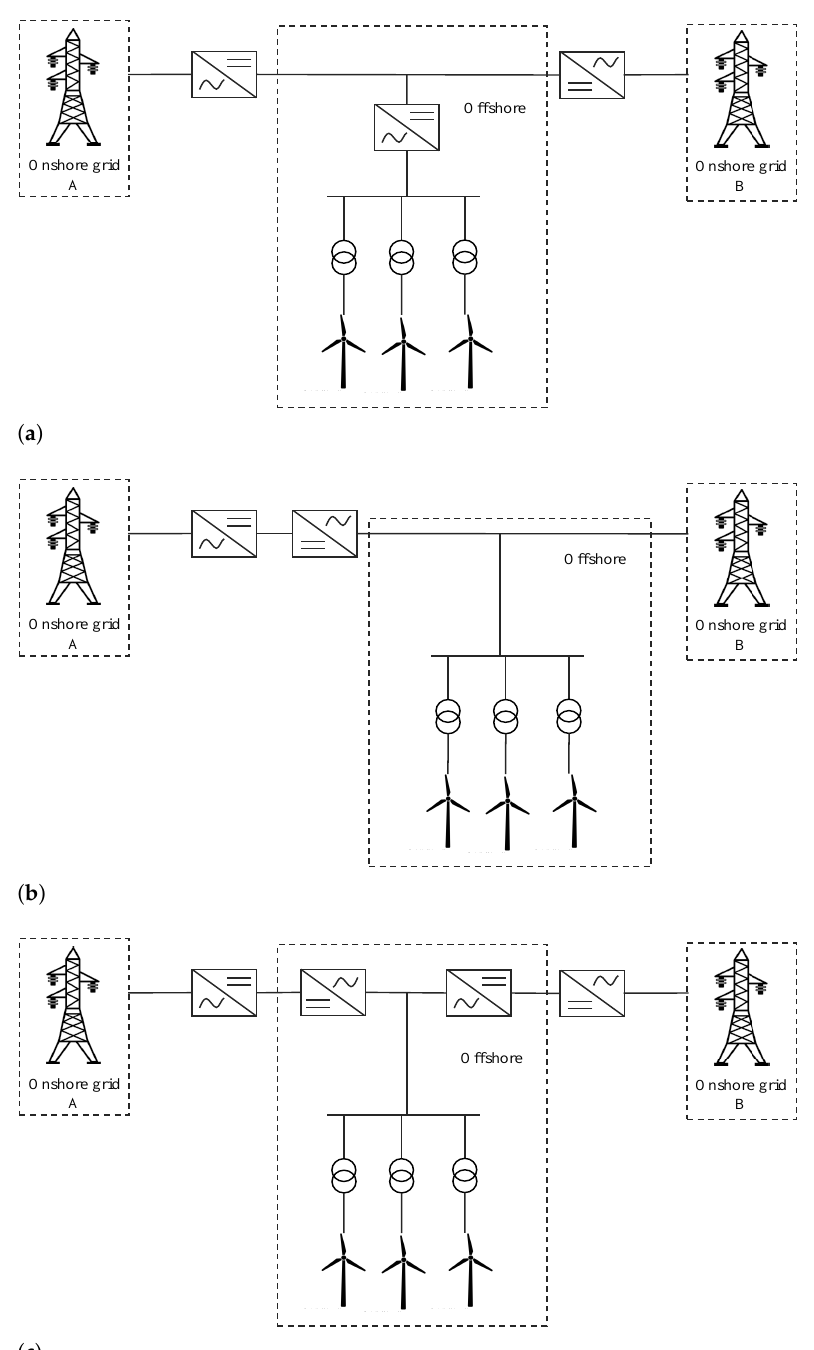
Figure 1. Different configurations available for Hub-and-spoke principle. ( a ) Hub-and-spoke with multi-terminal HVDC system; ( b ) Hub-and-spoke with AC links and HVDC back-to-back station; ( c ) Hub-and-spoke with multiple HVDC